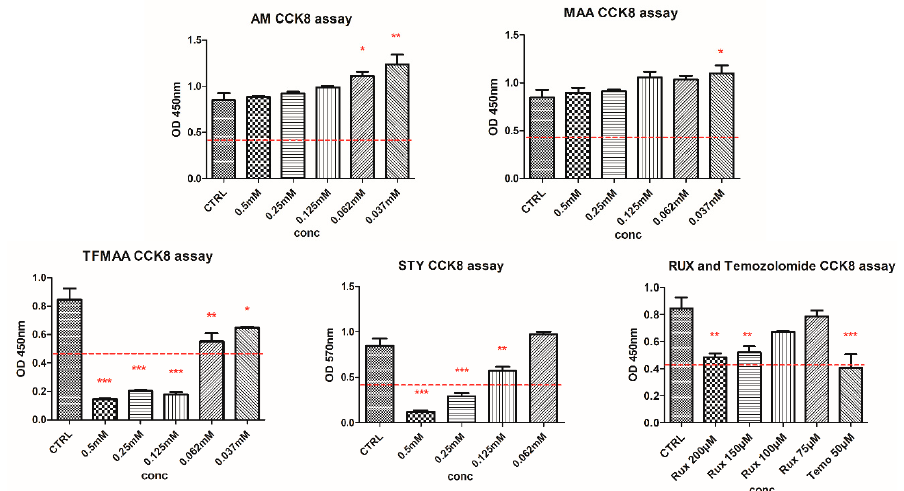
Figure 3. Graphical representation of CCK8 viability assay of C6 glioma cells exposed to different monomers (*** p < 0.001; ** p < 0.01; * p < 0.05).